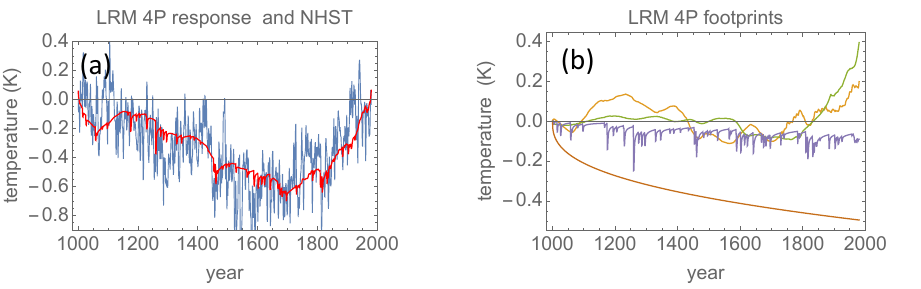
to the initial forcing F 0 as a predictor. Panel (b) : the 0 0